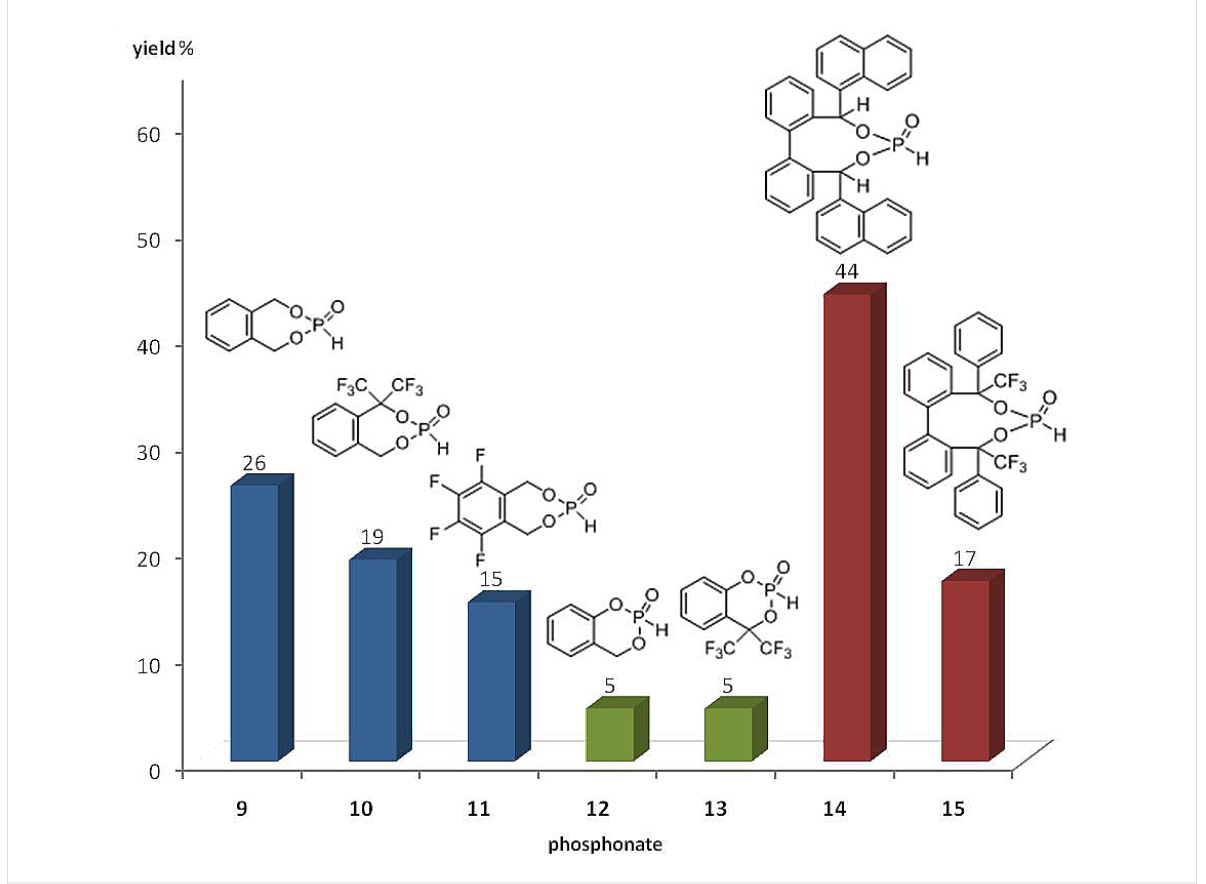
Figure 5: Phosphonate precatalysts 9 – 15 in cross benzoin